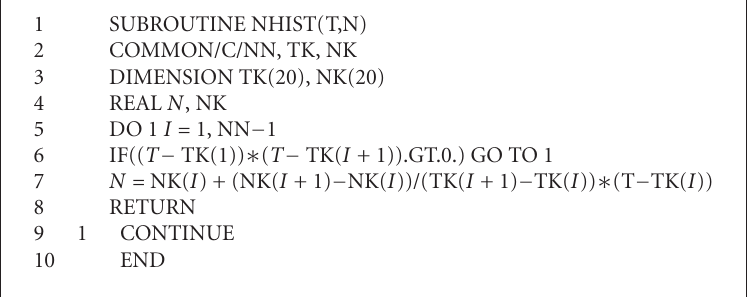
Algorithm 4: Subroutine